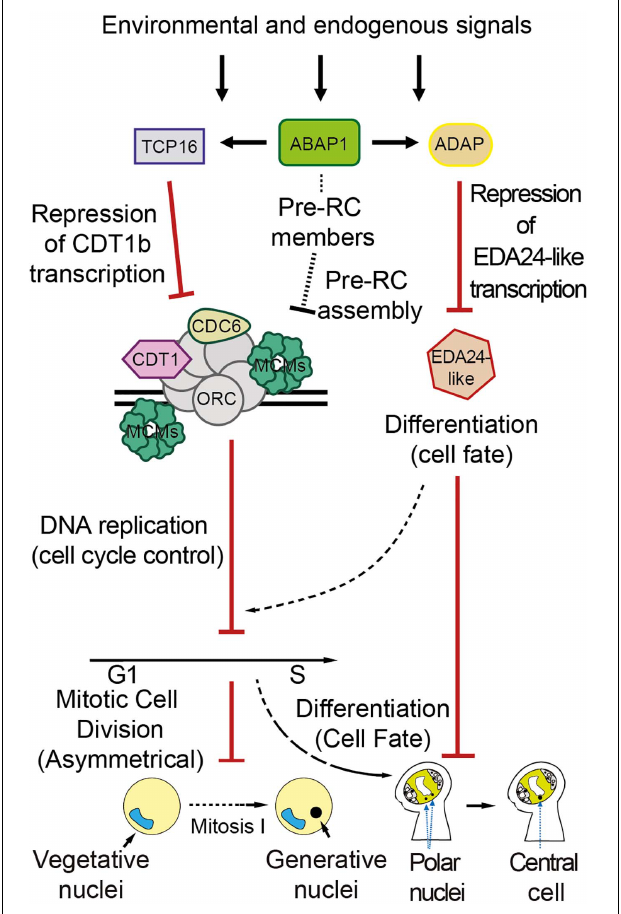
FIGURE 7 | Proposed model for ABAP1 role in the differentiation of male and female gametophytes. ABAP1, associated with transcription factors partners, might sense environmental and endogenous signals, triggering changes in gene expression patterns that will regulate male and female gametophytes differentiation. The molecular mechanism operating in the male gametophyte is similar to those previously described in leaves. In the first asymmetric cell division after meiosis, ABAP1 associates with TCP16, represses CDT1b transcription, controlling CDT1b homoeostasis. Lower levels of CDT1b might affect pre-RC functioning, limiting DNA replication. A direct association of ABAP1 with pre-RC members is still not determined. However, as described in leaves, it could also affect pre-RC assembly and DNA replication in the male gametophyte. In this way ABAP1 would regulate the timing of cell cycle progression at G1 to S. The mechanism of action in the female gametophyte involves association with another partner, ADAP, during embryo sac maturation. ABAP1-ADAP also represses gene transcription of EDA24-like that is necessary for polar nuclei fusion. Thus, ABAP1 might regulate the timing of polar nuclei fusion to form the central cell, that is crucial in pollen tube guidance. The involvement of DNA replication in the mechanism that regulates female differentiation is still not